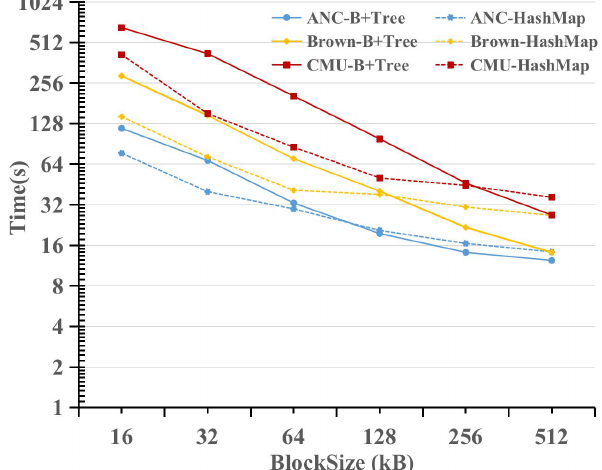
Figure 8. Comparison of the time between B+Tree and HashMap to update 50,000 words.